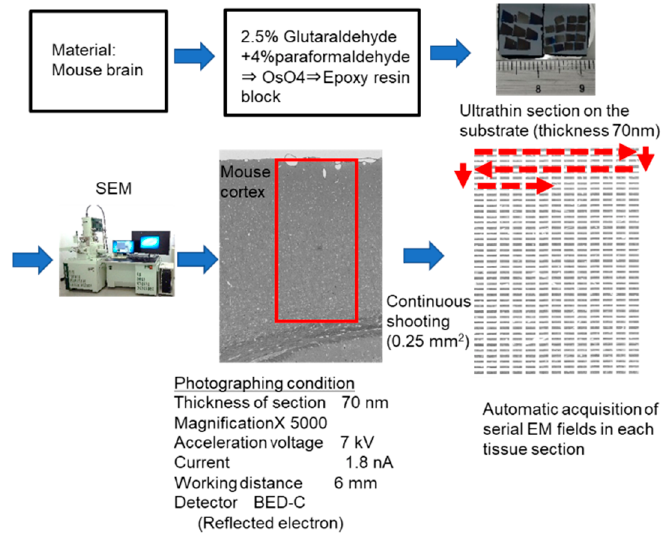
Figure 6. Automatic system for acquiring large-scale scanning electron microscopy images. Epoxy blocks of mouse cerebral cortex are sectioned at 70 nm, mounted on a substrate, and subjected to electron microscopy. Approximately 600 fields of view (0.25 mm 2 total) are automatically and continuously taken at 5000 × with a field emission-scanning electron microscopy (FE-SEM), and one unified image is produced by image processing. Red rectangle including the cortical surface and white matter indicates the automatic acquisition area. Red broken lines and arrows indicate the direction and sequential order of automatic acquisition of electron microscopic images.